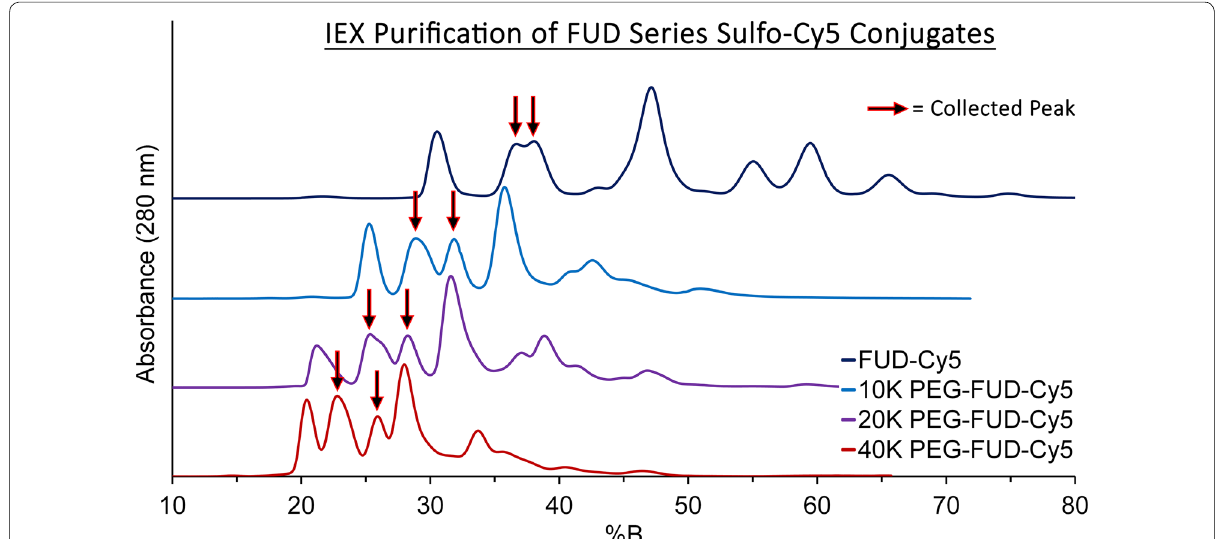
Fig. 3 Overlay of ion exchange chromatograms showing the separation of singly sulfo-Cy5 labeled FUD and 10–40 kDa PEG-FUD from the unreacted and multiply labeled peptides. The collected fraction containing the singly labeled drug is indicated with arrows. An anionic exchanger in conjunction with 20 mM Tris (pH 8) A side and 1 M NaCl in 20 mM Tris Buffer (pH 8) B side mobile phases were used to elute the